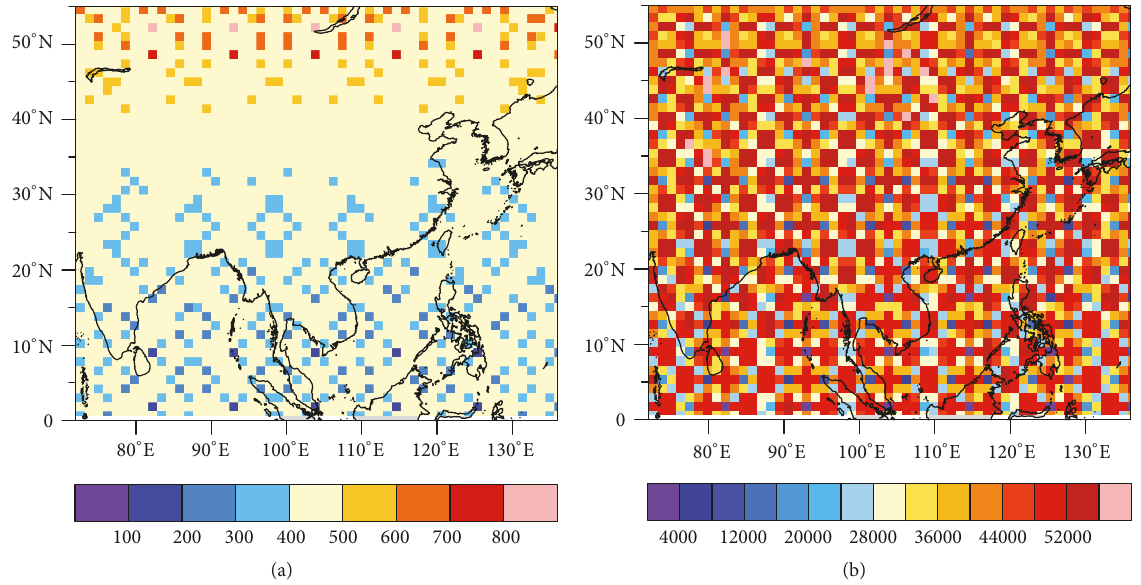
Figure 1: Spatial distribution of the numbers of (a) observation orbits and (b) observation profiles from 2006 to 2016 over China and surrounding